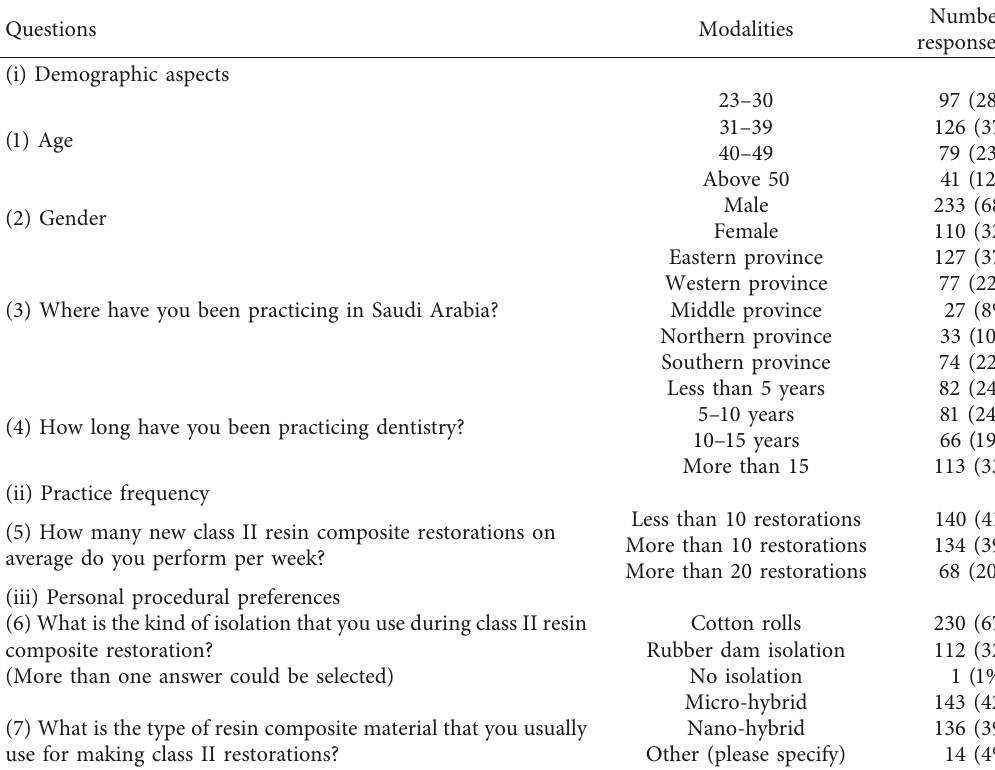
Table 1: Survey questions, responses, and